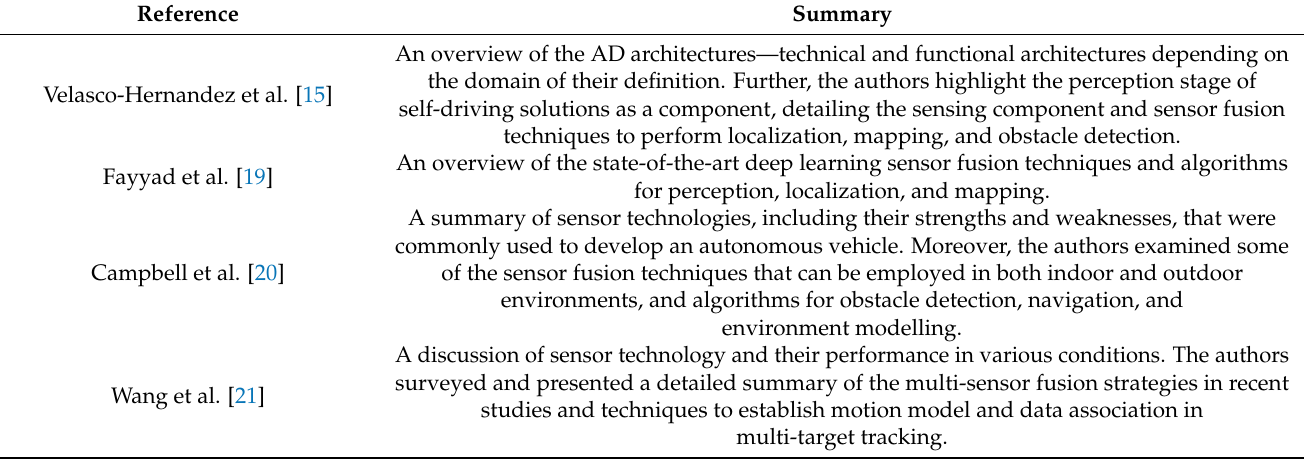
Table 1. Summary of recent studies on sensor and sensor fusion